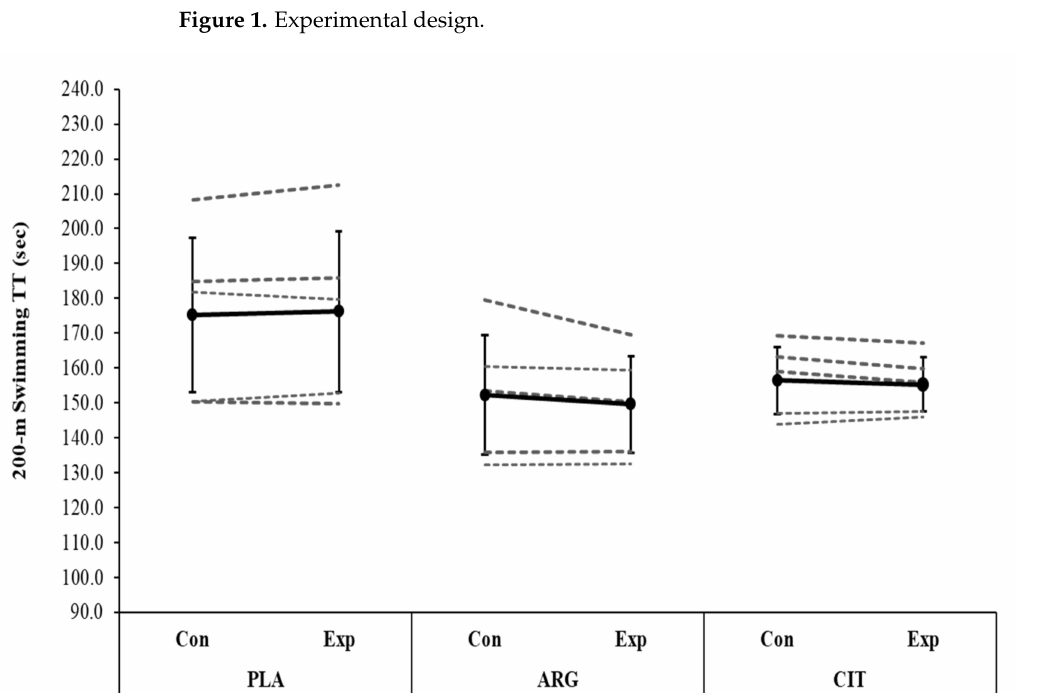
Figure 2. Group mean (SD) and individual 200 m swimming TT responses after 8-day L-citrulline or L-arginine or placebo supplementation are shown in the black and dashed lines, respectively. PLA, placebo; ARG, L-arginine; CIT, L-citrulline; Con, control trial; Exp, experimental trial; TT, time